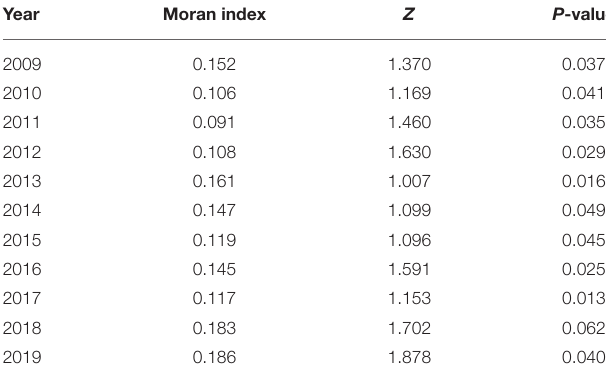
region has been significantly improved. Tourism in Xinjiang TABLE 4 | Global Moran index of health production efficiency from 2009 to